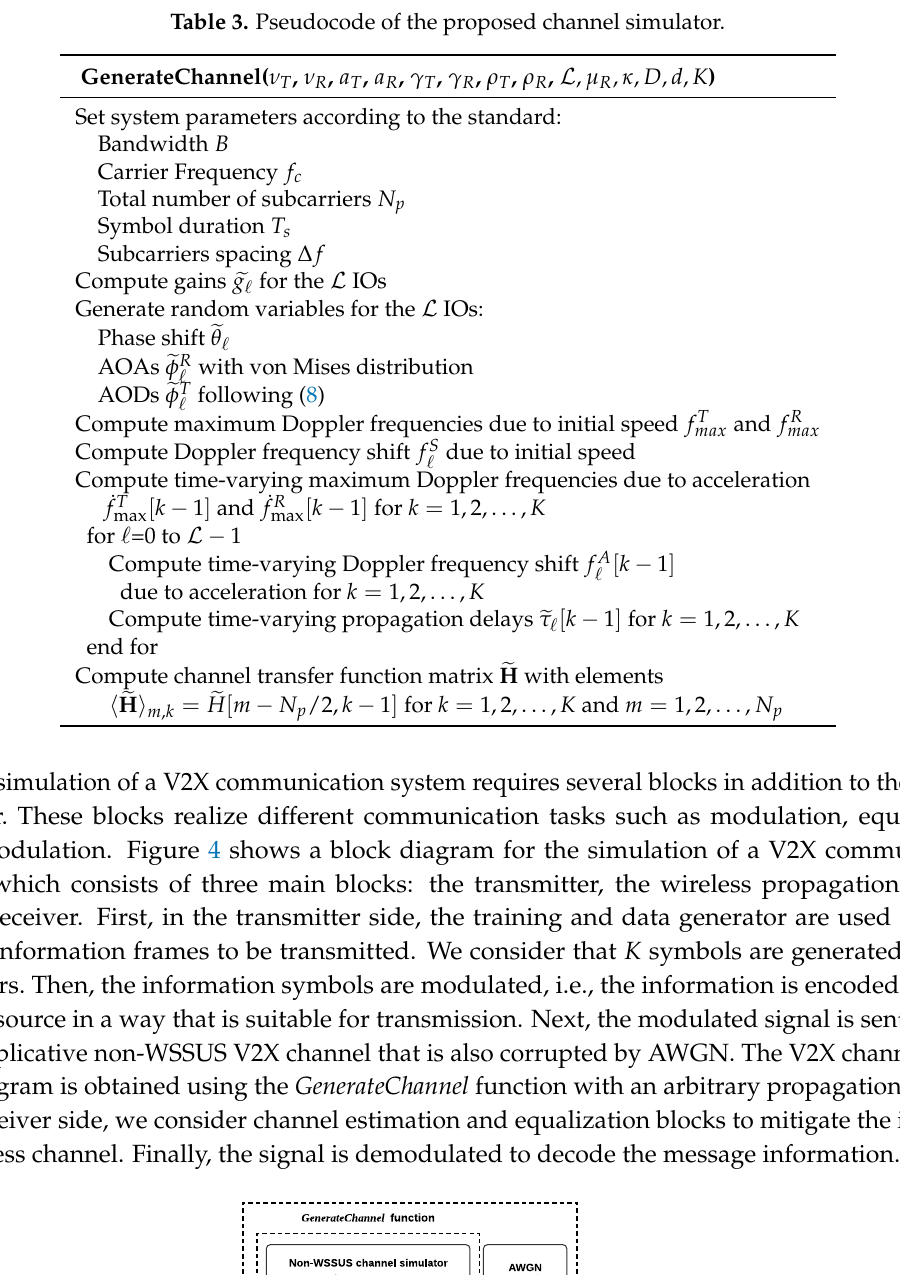
Table 3. Pseudocode of the proposed channel simulator.